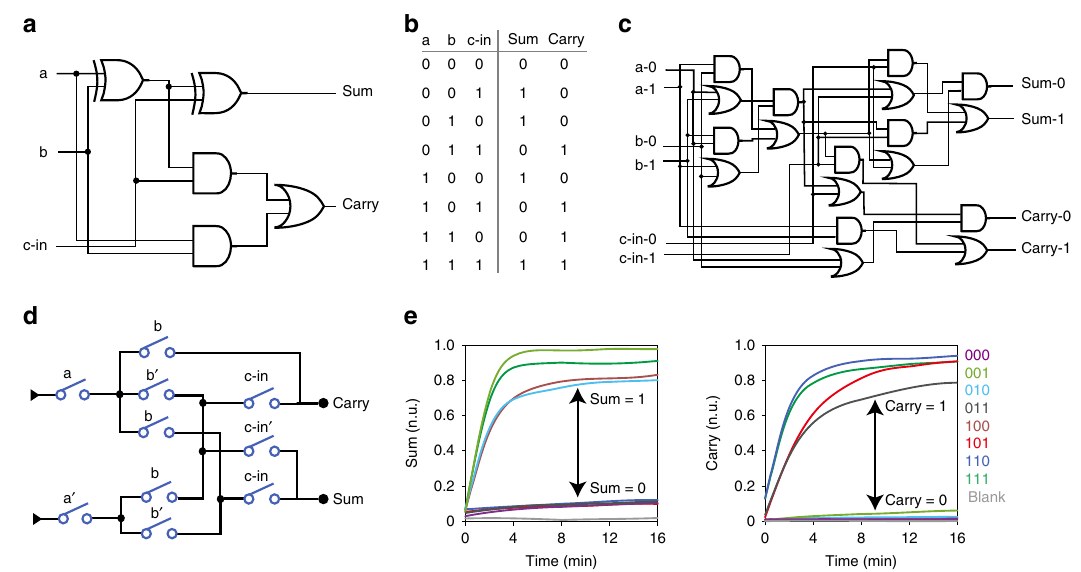
Fig. 5 Implementing a full-adder with a DSC. a – d Logic gate diagram ( a ), truth table ( b ), dual-rail representation ( c ), and switching circuit diagram ( d ) of the full-adder circuit. e Fluorescence readout of sum (left) and carry (right) with all possible combinations of inputs. Source data are provided as a Source Data fi